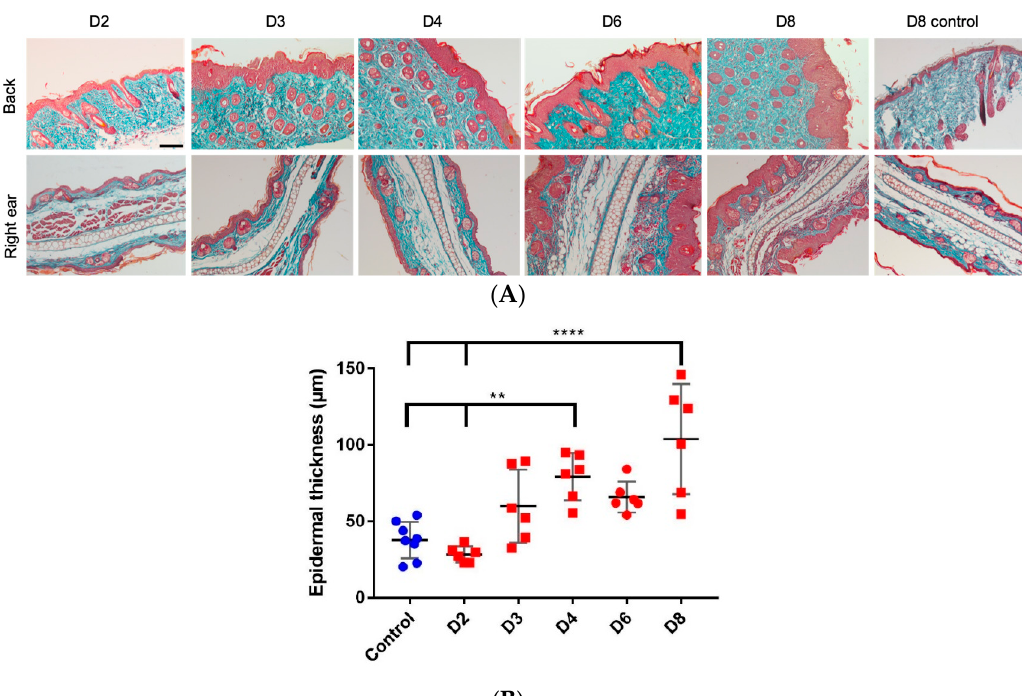
Figure 4. ( A ) Histological examination by Masson’s trichrome staining of back and right ear samples (scale bar = 100 μ m for each image). ( B ) Measurement of epidermal back thickness for 8 days of IMQ application; measurements were made by two different persons on 3 images, for each day ( n = 3) and statistically analyzed using one-way ANOVA followed by Tukey’s multiple comparison test. **: p < 0.01; ****: p < 0.0001.